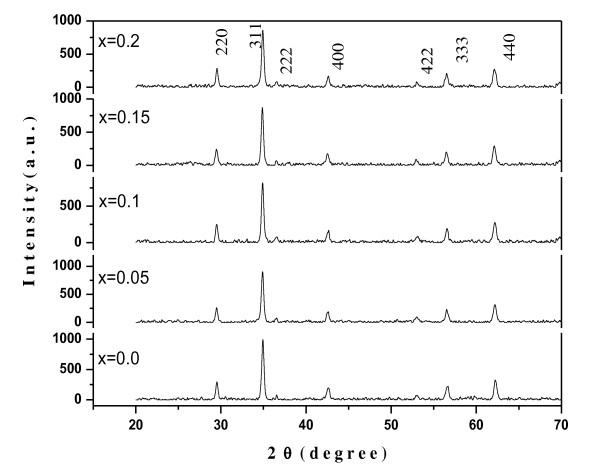
XRD pattern of powdered Ni0.7-xCu0.3ZnxFe2O4 (0.0 ≤ x ≤ 0.2, x = 0.05) ferrite nanoparticles.